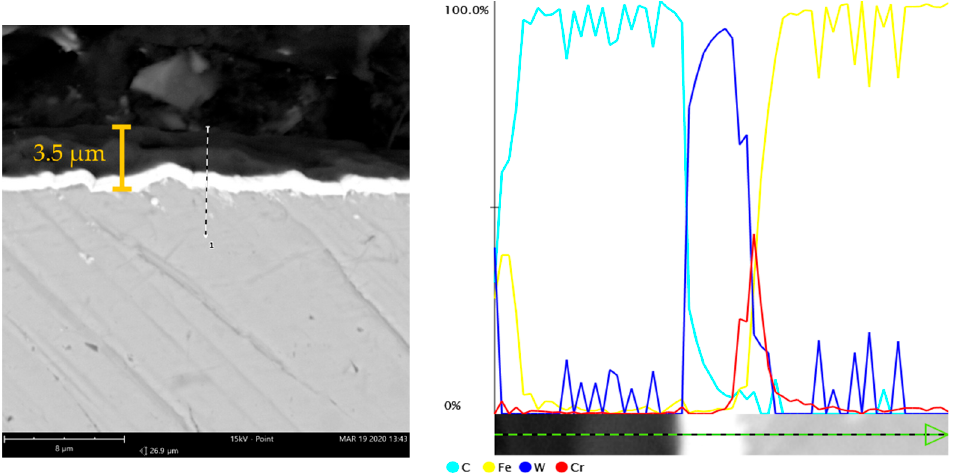
Figure 2. SEM microphotograph and results of the EDS line profile analysis of the W-DLC coating.